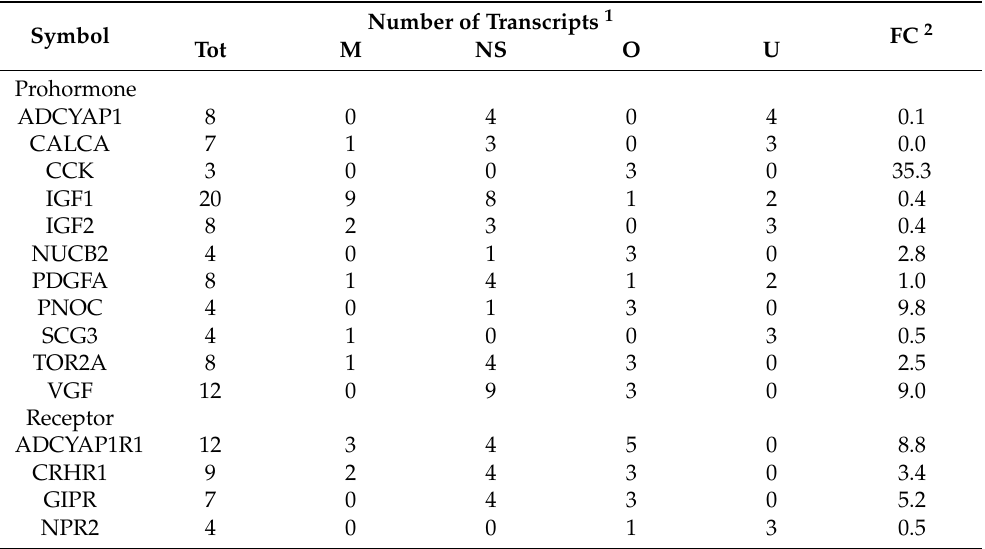
Table 4. Frequency of significant (FDR-adjusted p -value < 0.05) differentially expressed neuropeptide prohormone and receptor transcript isoforms between nucleus accumbens and trigeminal ganglia. Number of Transcripts 1 Symbol